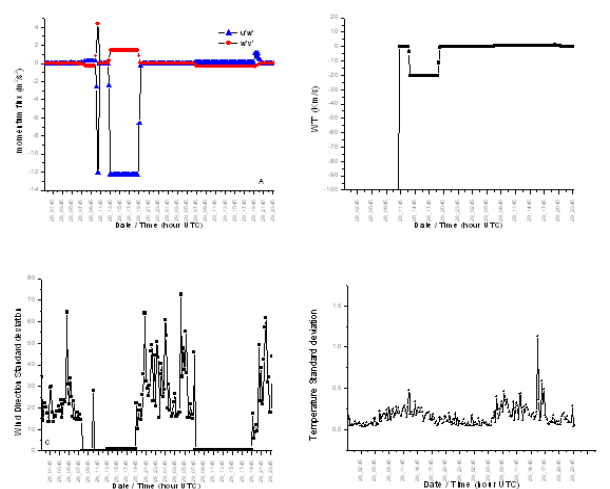
Figure 8 : Diurnal trends of u/v momentum flux (A), eddy heat flux (b) and wind direction standard deviation (c) and temperature standard deviation (d) at Harrison